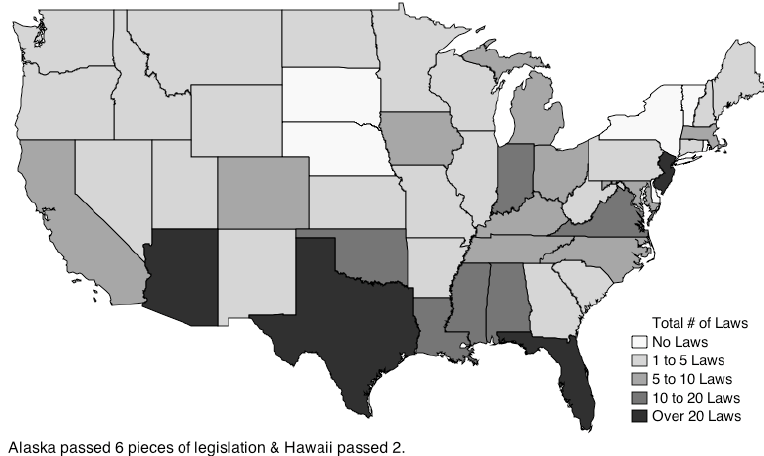
Figure 2. Faith ‐ based legislation 1996–2009. Figure 2. Faith-based legislation